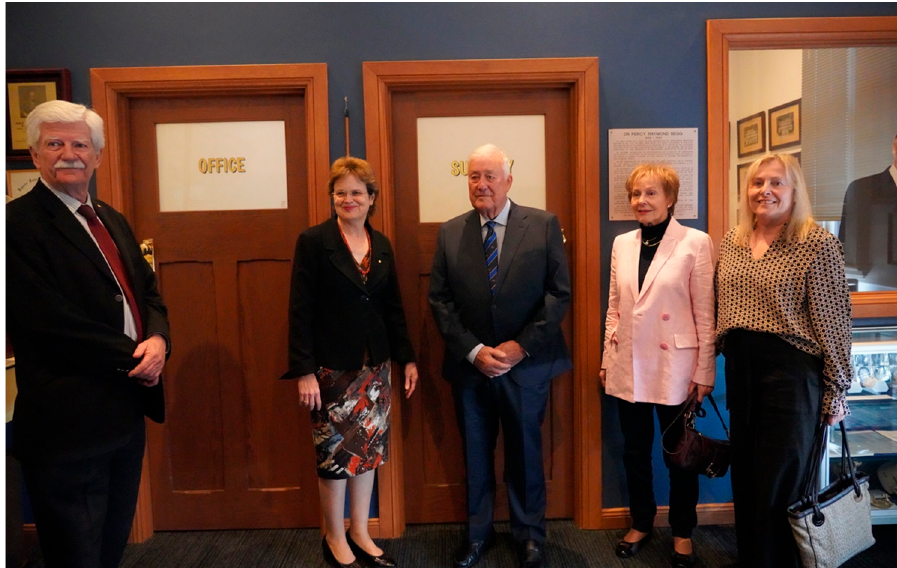
Figure 1. Left to right: Emeritus Professor Wayne Sampson AM, Her Excellency the Honourable Frances Adamson, AC (Governor of South Australia) alongside members of the Begg